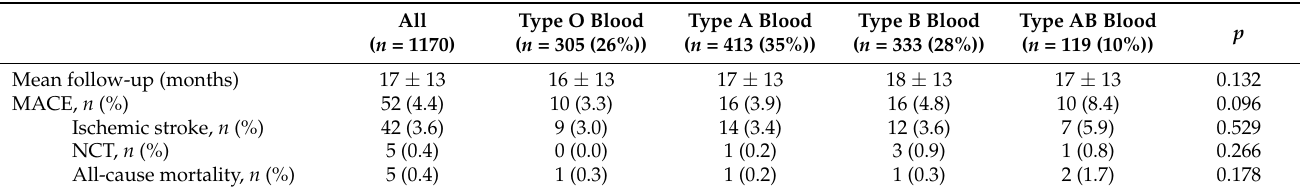
Table 2. Long-term outcomes by blood type.